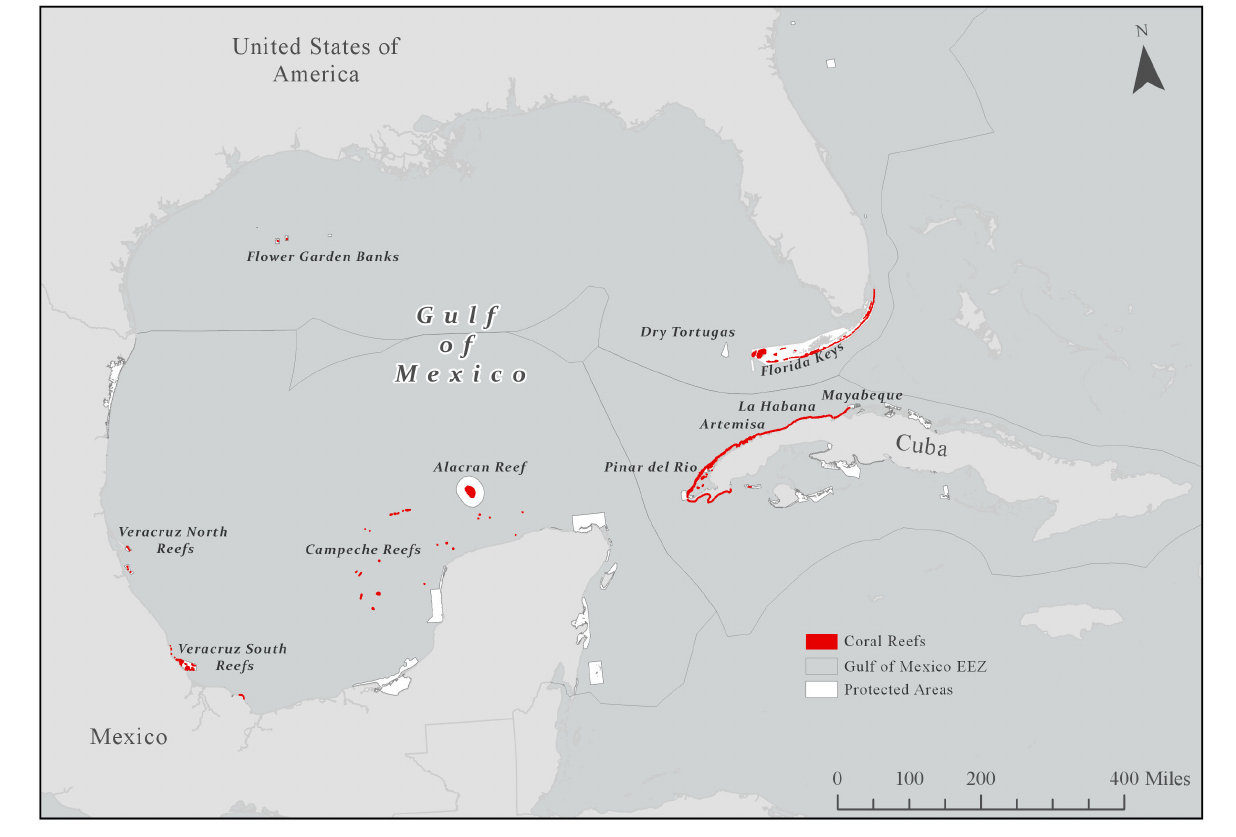
FIGURE 1 | Distribution of shallow coral reefs (red) in the Gulf of Mexico (GoM). Exclusive Economic Zone = EEZ. Also shown are managed areas within the GoM, which tend to be focused on fisheries